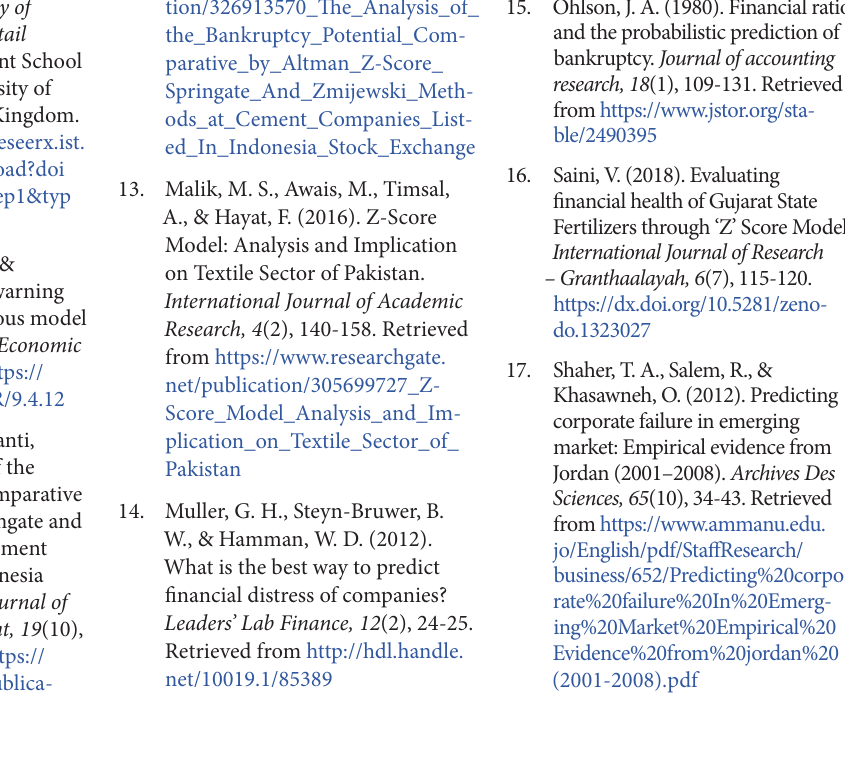
Table A1. List of 30 listed companies on Vietnamese stock market from 2015 to